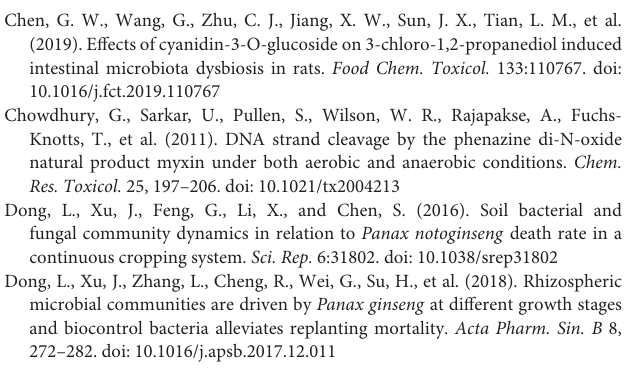
FIGURE S1 | Field experiment layout. A, B, C, and D represents four probiotics consortia, E represents biopesticide (Shandong Kaoshan Biotechnology Co., Ltd., China), and JKT represents light diseased plants treated with water. BT represents severe diseased plants (control) treated with water. R and T represent repeats. FIGURE S2 | Comparison of Bacterial (a) and Fungal (b) OTUs control group JKT and BT in treatment group A, B, C, D, and E. A, B, C, and D represents four probiotics consortia, E represents biopesticide (Shandong Kaoshan Biotechnology Co., Ltd., China), and JKT represents light diseased plants treated with water. BT represents severe diseased plants (control) treated with water. FIGURE S3 | Heatmap representing their relative abundance. (a) . Heatmap analysis showing the distribution of the core bacterial genera. (b) . Heatmap analysis showing the distribution of the core fungal genera. Generation of a mapping image based on abundance in formation. To examine the abundance information available at the species level, we selected genera represented by the 30 most abundant sequences to draw a species abundance cluster map. Abscissae indicate sample information, and ordinates indicate species annotation information. The cluster tree on the left side of the figure is a species cluster tree; a sample cluster tree is shown above the cluster tree. Each soil sample all collected from three replicate plots. TABLE S1 | List of the bacteria strains used in this study. TABLE S2 | Four probiotic consortia assembled by 13 different bacteria strains. TABLE S3 | Suppression effects on diseased Panax notoginseng